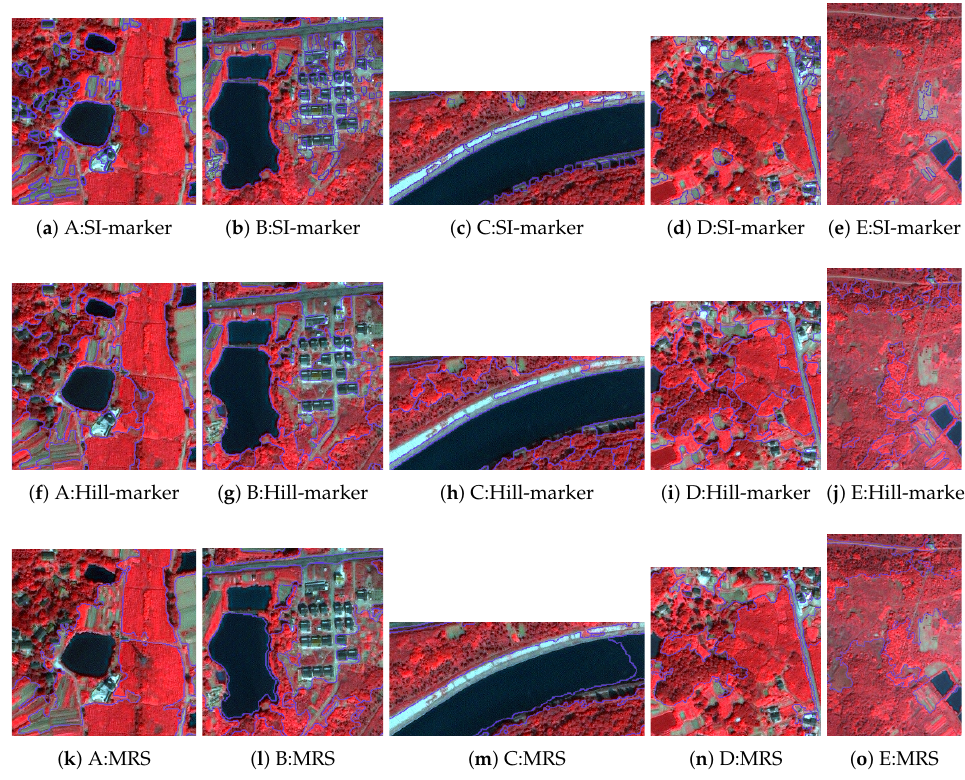
Figure 16. The segmentation result of Regions A, B, C, D, and E of dataset D1 based on the SI-marker method, the Hill-marker watershed segmentation method, and the MRS